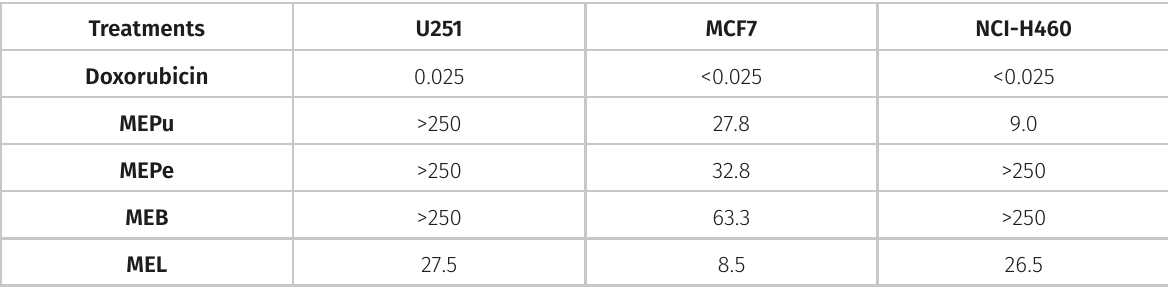
a Human cancer cell lines: U251 (glioma); MCF-7 (breast); NCI-H460 (large cell lung cancer). Assessed by the SRB assay. b GI50 values represent the concentration required to inhibit 50% of cell